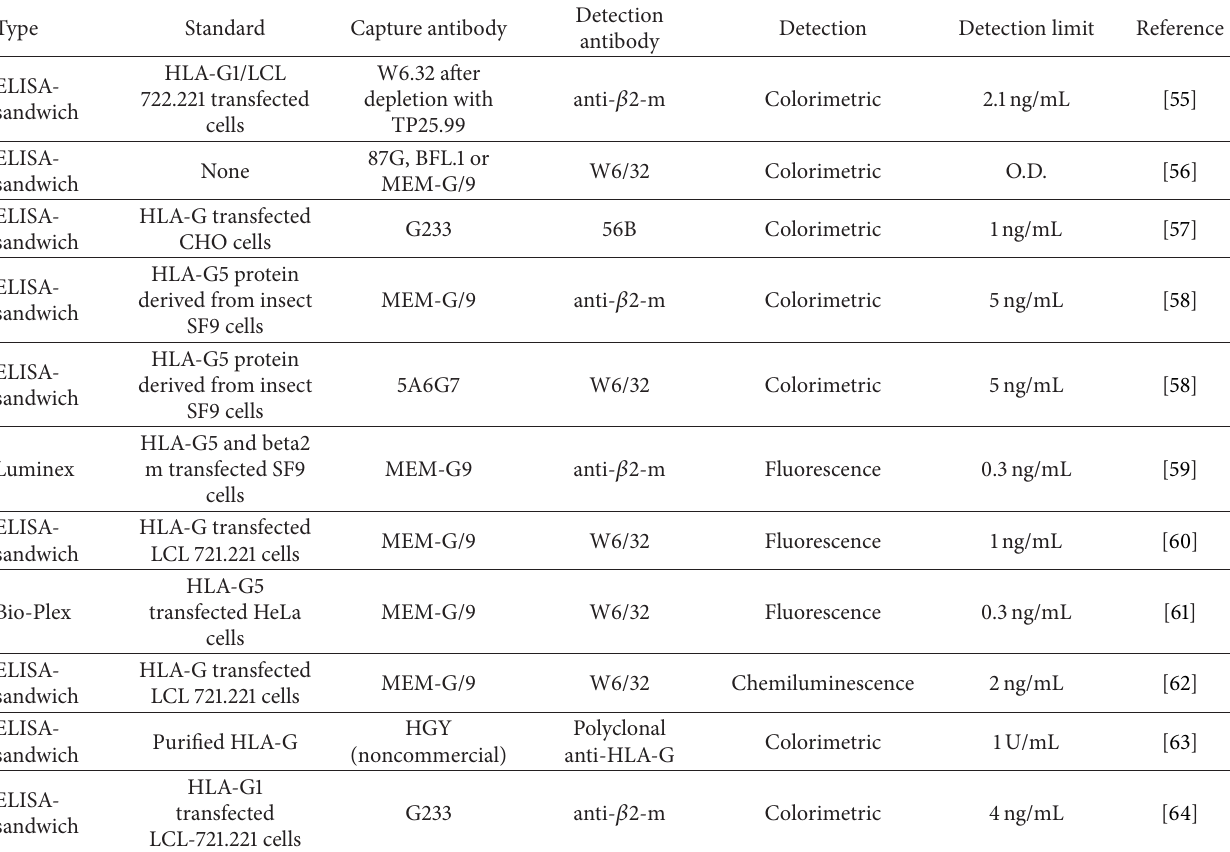
Table 1: Examples of methods developed for measuring soluble